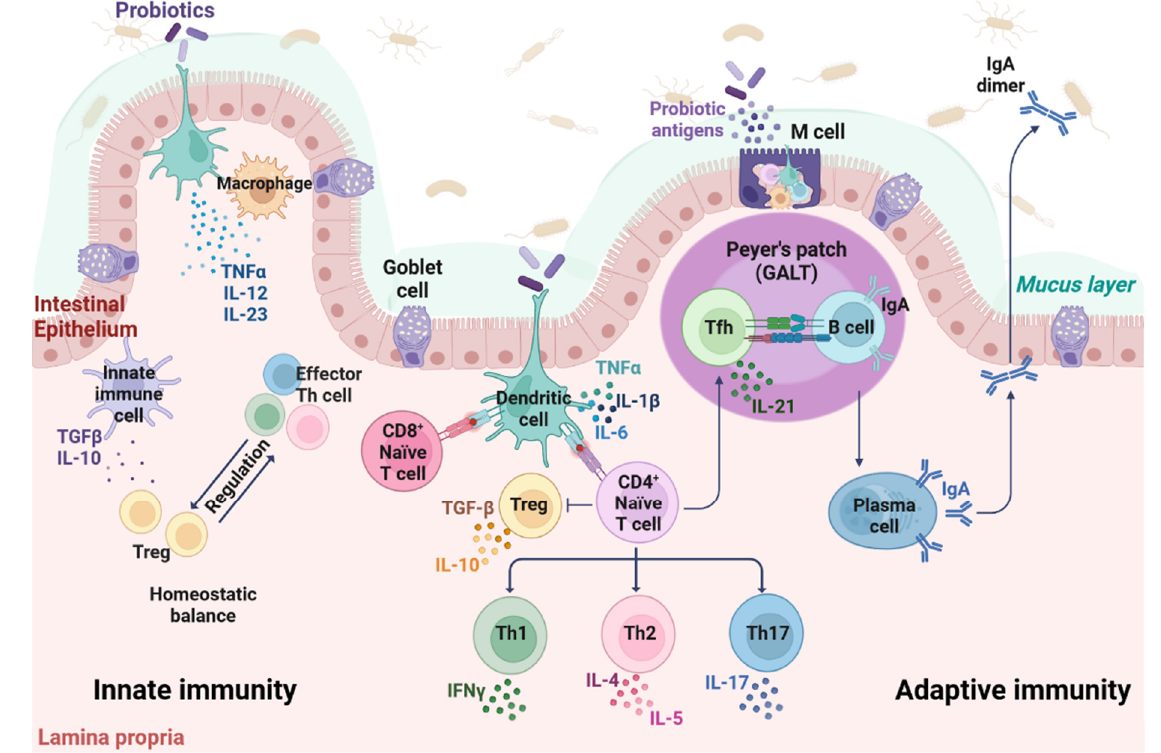
Figure 1. Schematic representation of the interaction between host intestinal immune cells and pro- biotics. Probiotics play a role in host innate and adaptive immune responses by modulating immune cells such as dendritic cells (DCs), macrophages, and B and T lymphocytes. Interactions between host intestinal cells and probiotics mainly occur at the surface of the intestinal barrier, including the intestinal epithelium and the underlying lamina propria. Intestinal microbiota is separated from the intestinal epithelium by a mucus layer secreted by goblet cells. Consumed probiotic bacteria adhere to intestinal epithelial cells and activate them by pattern recognition receptors (PRRs). Cytokines stimulated by probiotic bacteria lead to the activation of T regulatory (Treg) cells, which maintain immune homeostasis in the intestinal mucosa. Tregs are effective suppressors of the immune re- sponse and play a key role in limiting immune response. Intestinal antigens are transferred to DCs via specialized enterocytes known as microfold cells (M cells), which are located in the epithelium overlying Peyer’s patch. Probiotics are processed directly by DCs in lamina propria in the intestinal lumen. Intestinal DCs can activate CD8+/CD4+ naïve T cells and direct helper T cell responses to- wards Th1, Th2, Th17, or regulatory patterns. The Th1 immune response is mainly characterized by interferon (IFN)- γ production and is involved in cell-mediated immunity. The Th2 immune re- sponse includes interleukin (IL)-4, IL-5 release, thus inducing humoral immunity. The Th17 immune response is characterized by IL-17 production. Induction of Tregs releases IL-10 or transforming growth factor (TGF)- β . In addition, probiotics induce maturation of B cells into immunoglobulin (Ig)A-producing plasma cells. Intestinal epithelial cells release cytokines and chemokines, creating a microenvironment in the lamina propria of the intestine that allows the clonal expansion of B cells to produce IgAs. IgAs migrate through the epithelium into the mucus layer where they control bac- terial adhesion to the host tissue.